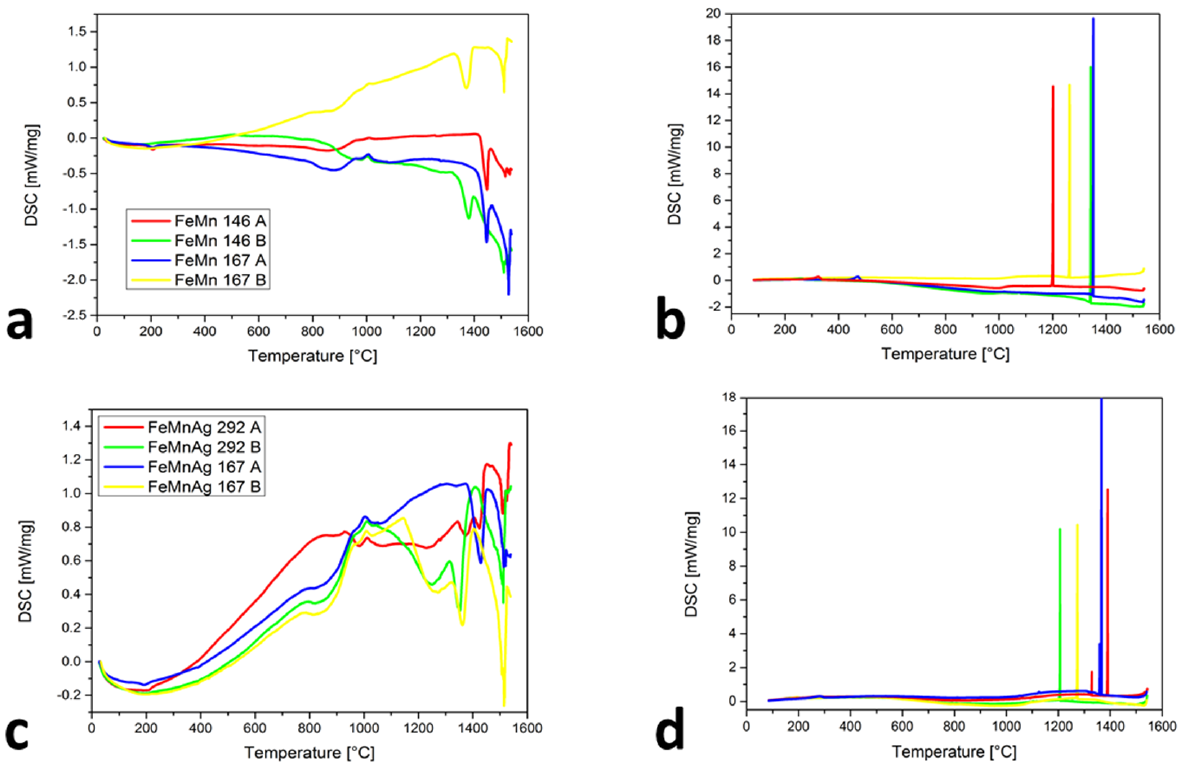
Figure 2. DSC results of SLM samples: ( a ) heating cycles for Fe-Mn samples, ( b ) cooling cycles for Fe-Mn samples, ( c ) heating cycles for Fe-Mn-Ag samples, ( d ) cooling cycles for Fe-Mn-Ag samples.